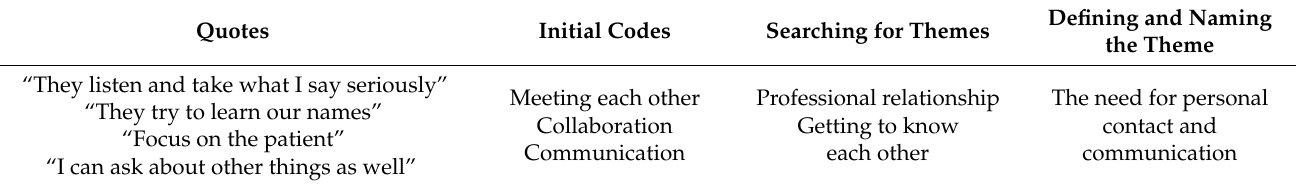
Table 2. Example of analysis from quotes to